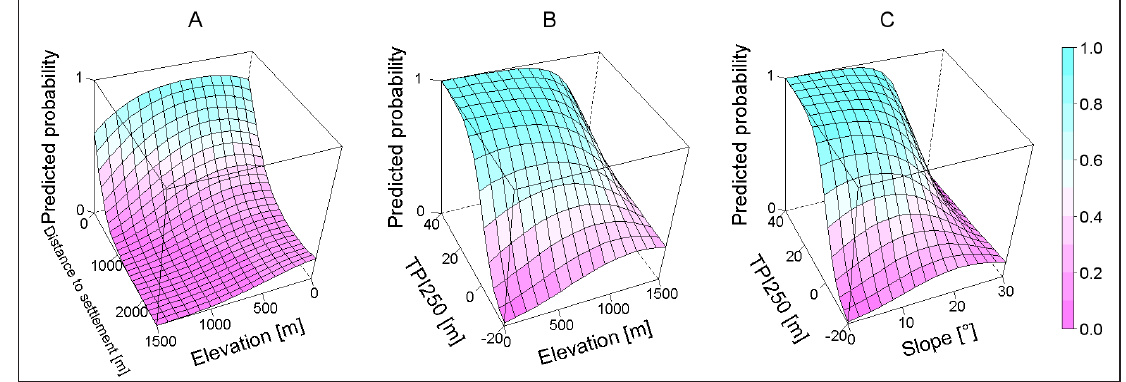
Figure 7: Response surfaces of the variables with significant interaction terms illustrating the predicted probability of occurrence of a SaS dependent on (A) Elevation / Distance to settlement, (B) TPI250 / Elevation and (C) TPI250 / Slope (with the other explanatory variables set to median or